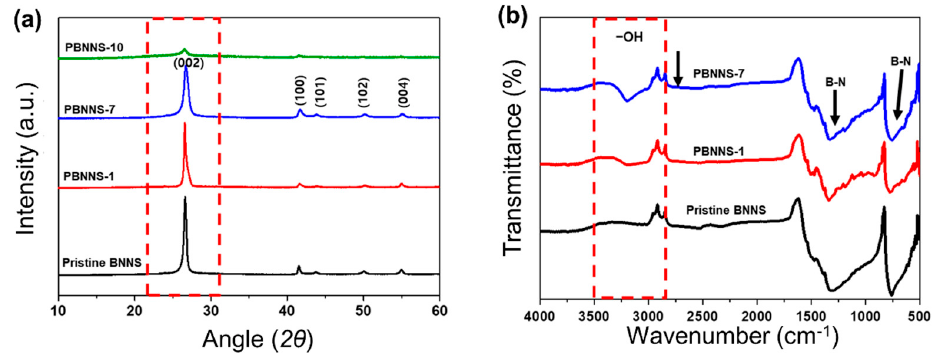
Figure 3. Characterization of PBNNS: ( a ) XRD spectra and ( b ) FT-IR spectra.